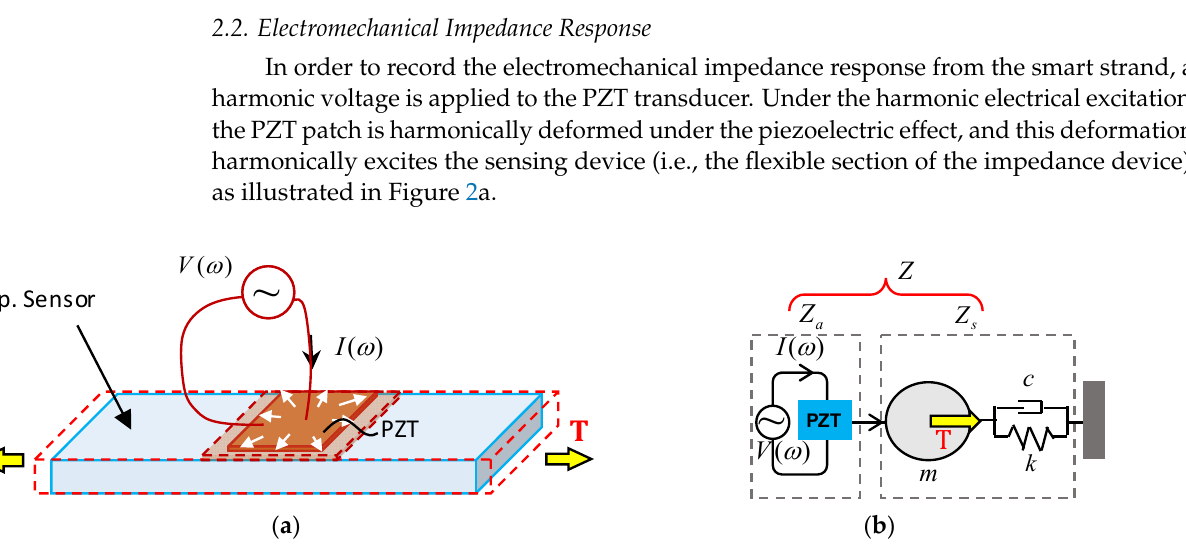
Figure 2. Illustration of transducer and structure interaction ( V( ω ) : applied voltage, I( ω ) : current, T : axial load, Z a : impedance of PZT, Z s : impedance of host structure, m : mass, c : damping, and k : stiffness constant). ( a ) Piezoelectric deformation; ( b ) 1-dof